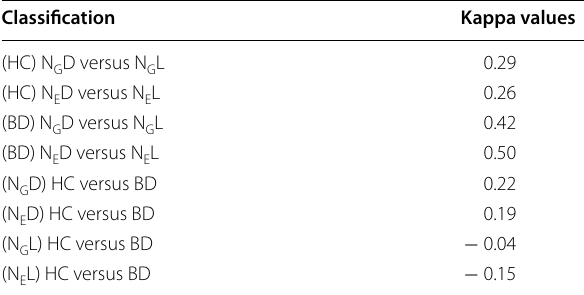
Larger values indicate better predictions. Abbreviations are as follows: HC healthy controls; BD = N E L Neutral Look; N G D =